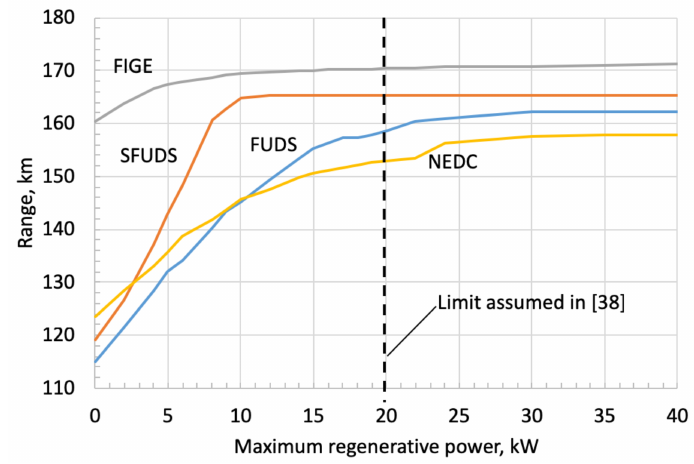
Figure 11. Driving range as a function of the limit on the maximum power for regenerative braking at 20 ◦